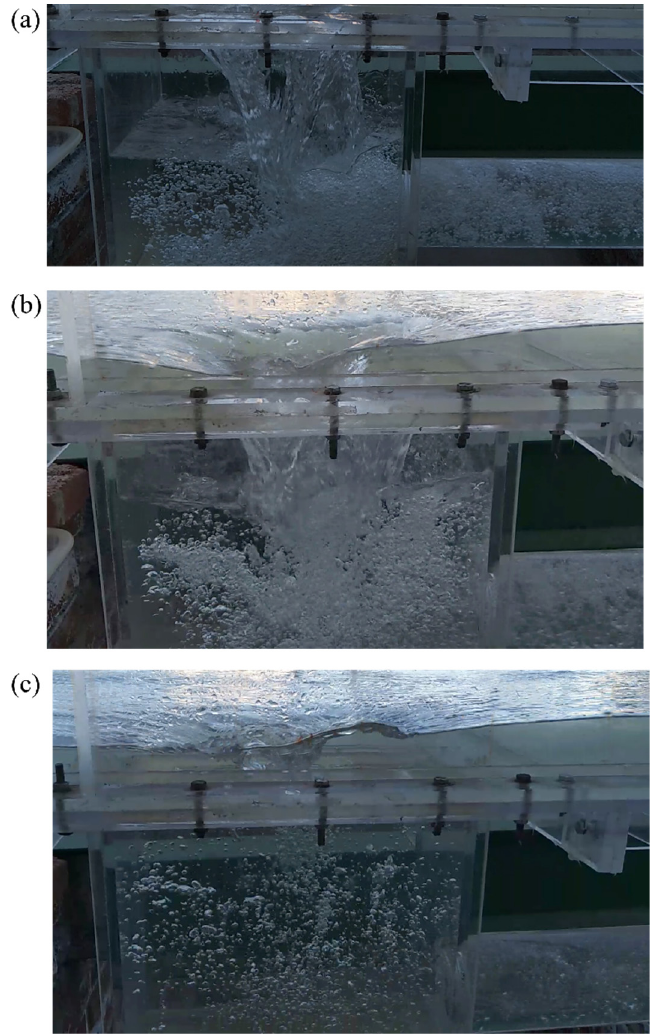
Figure 3. Flow state under different conditions. ( a ) and ( b ) are weir flow patterns of inlet with few and more water in rainwater well, respectively; ( c ) orifice flow pattern of inlet.